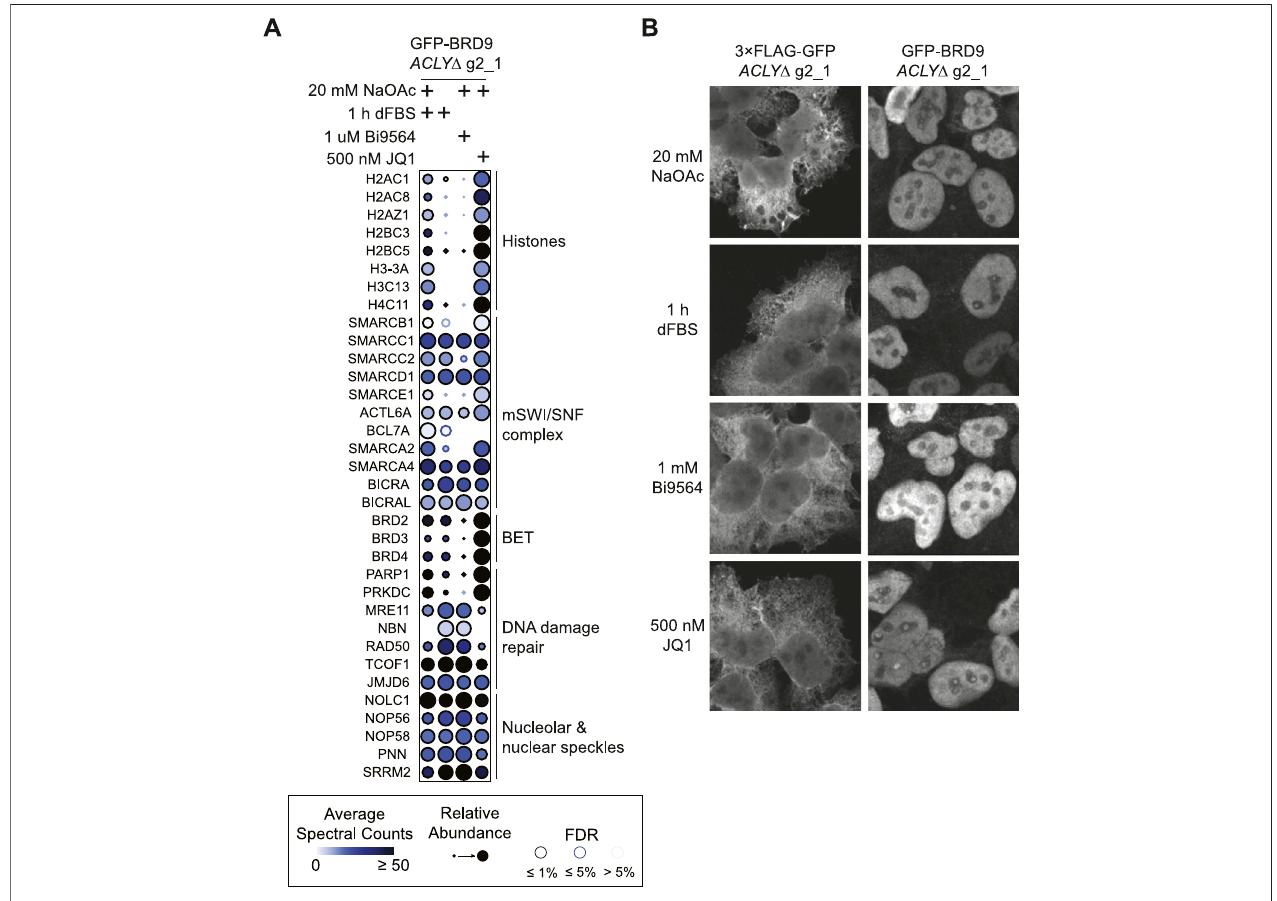
FIGURE 6 | Reorganization of the BRD9 interactome upon Kac depletion. (A) Dot plot of selected interaction partners of GFP-BRD9 identi fi ed by AP-MS of HEK293 ACLY Δ g2_1 cells treated with or without 20 mM NaOAc and treated with 10% dFBS, 1 μ M Bi9564, or 500 nM JQ1 for 1 h. (B) Immuno fl uorescence of GFP- BRD9andGFP-3×FLAGinHEK293 ACLY Δ g2_1cellsincubatedwithandwithoutNaOAcinmediumcontaining10%dFBSfor1 h.CellswereimmunostainedforGFP.